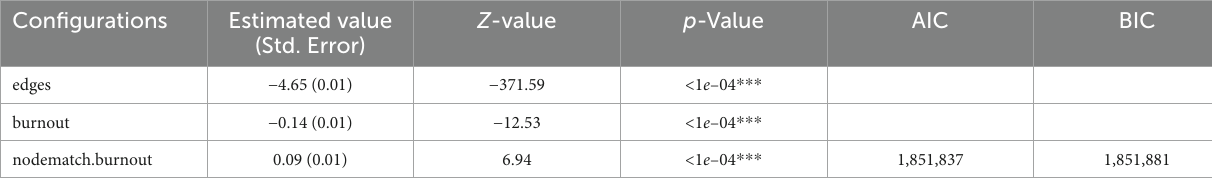
TABLE 2 Estimated values of coefficients and statistical test results for exponential random graph model (ERGM) model.